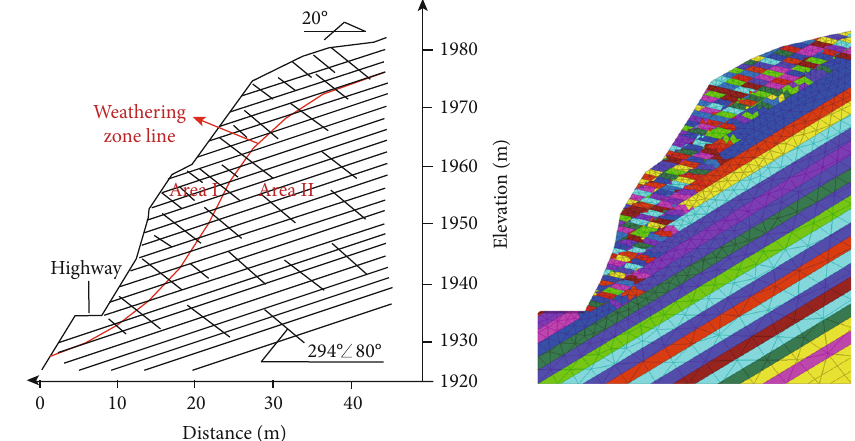
Figure 2: The typical section applied in numerical Table 1: Parameters of materials in freeze-thaw area (area I).